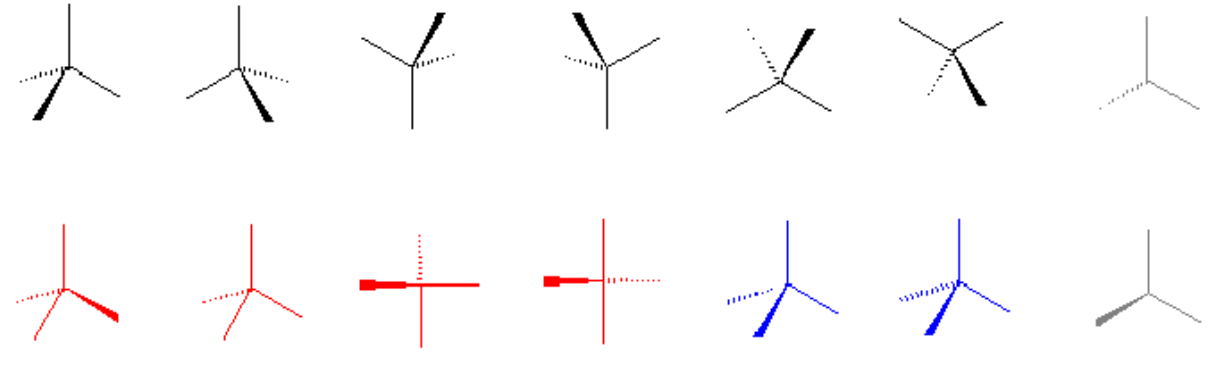
Figure 1. Correct (black and gray) and incorrect (red or blue) representations of a tetrahedron.